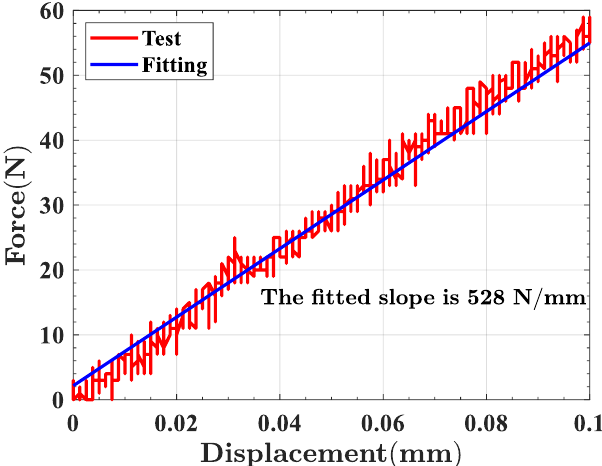
Figure A3. The displacement and tensile test results of the Fe 78 Si 13 B 9 ribbons. The length of the tested Fe 78 Si 13 B 9 ribbons was 54 mm, the width was 9.5 mm, and the thickness was 0.035 mm. Moreover, according to Equation (2), the elastic modulus and tensile stiffness of the Fe 78 Si 13 B 9 ribbons can be calculated as 85.75 GPa and 28512 N.